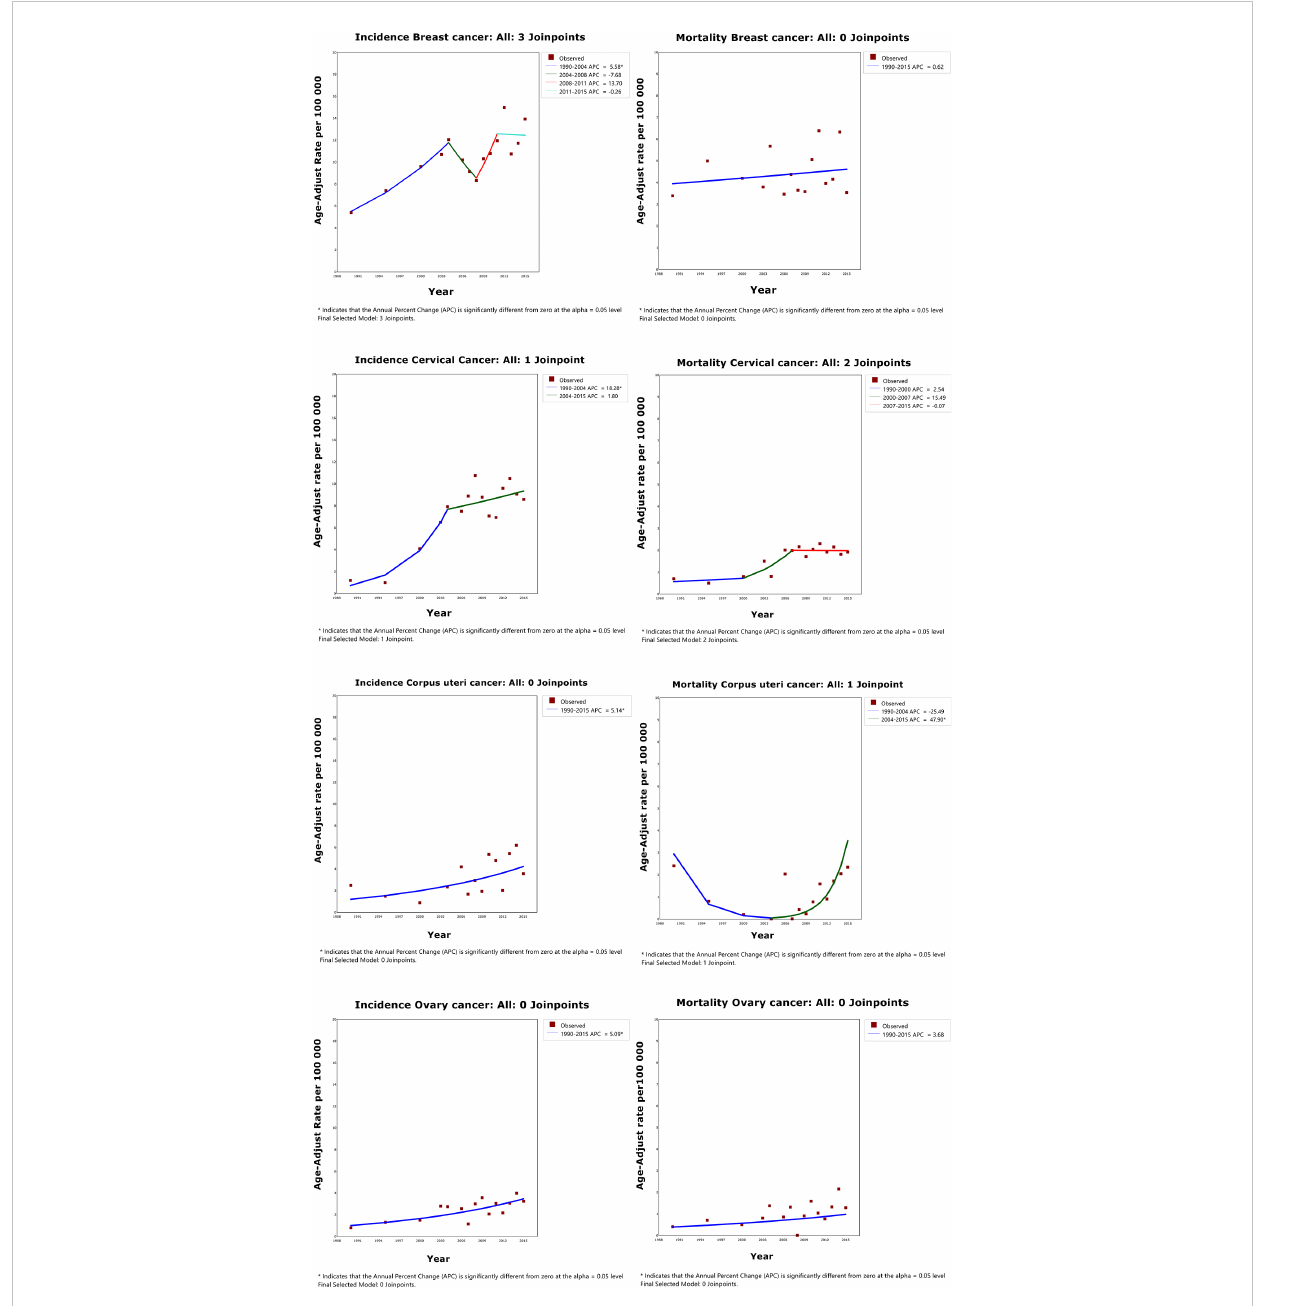
FIGURE 1 Trends in cancer incidence and mortality in